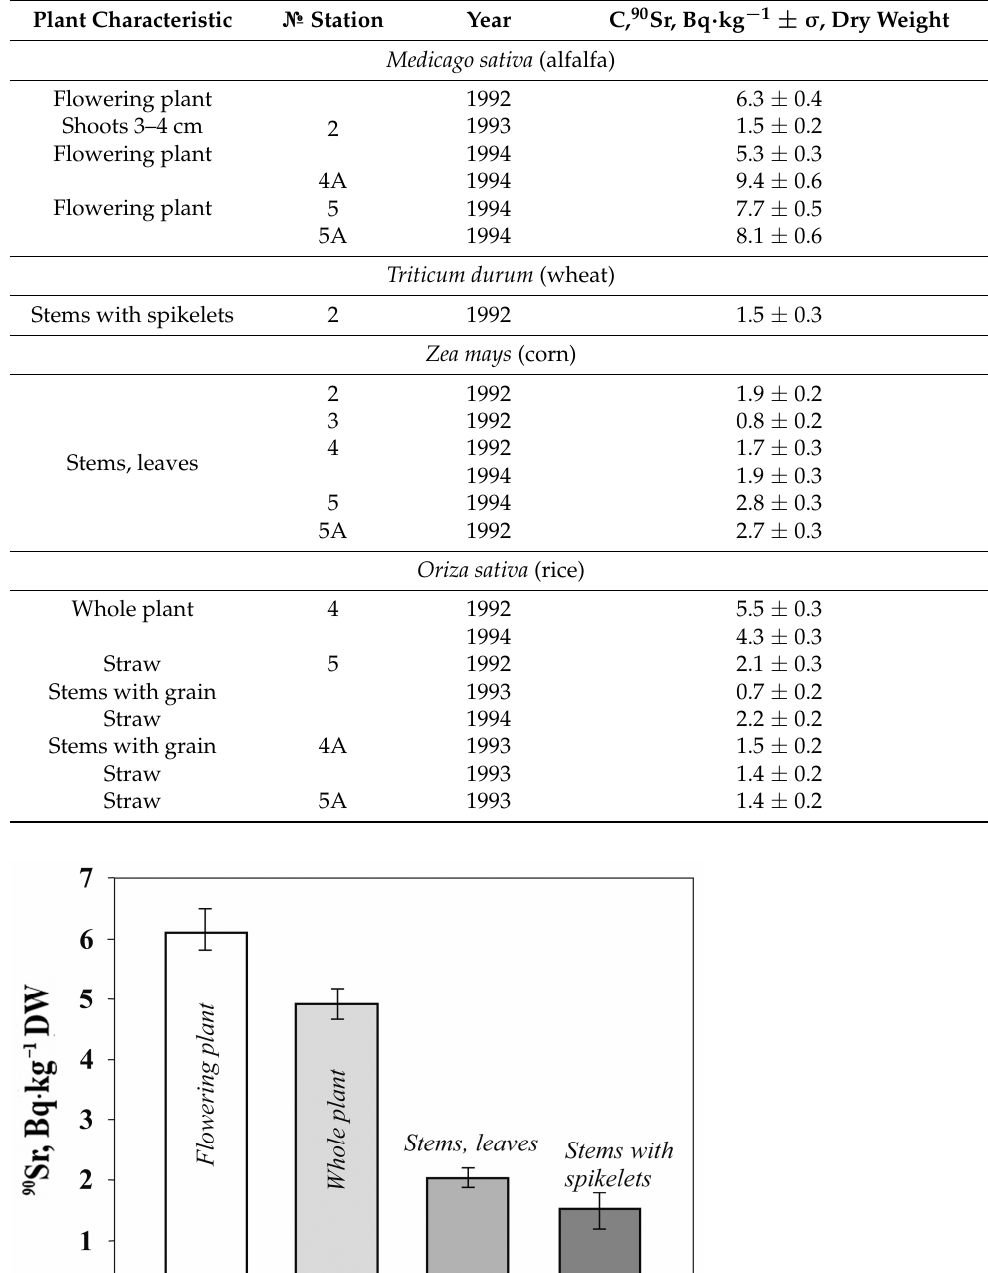
Table 3. Concentrations (C) of 90 Sr in cultivated plants collected from fields irrigated by the Dnieper water in 1992–1994.